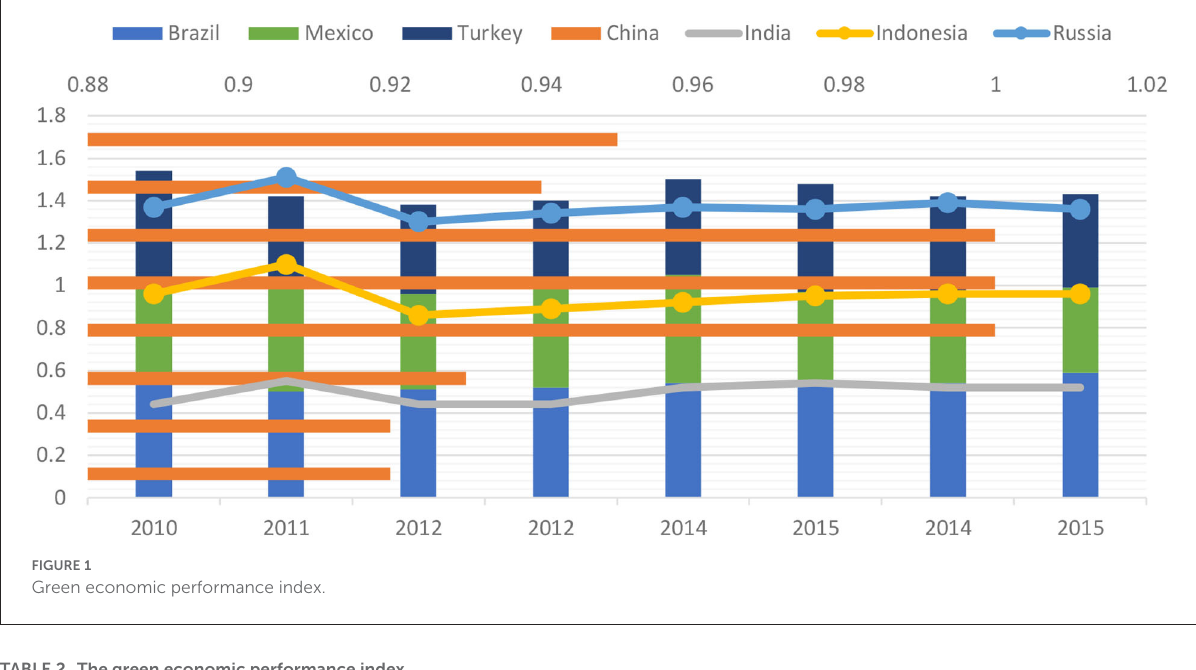
TABLE 2 The green economic performance index.